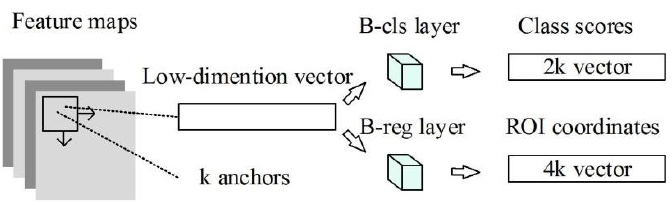
Figure 1. Schematic diagram of the region proposal network (RPN) structure. ROI = region of interest.